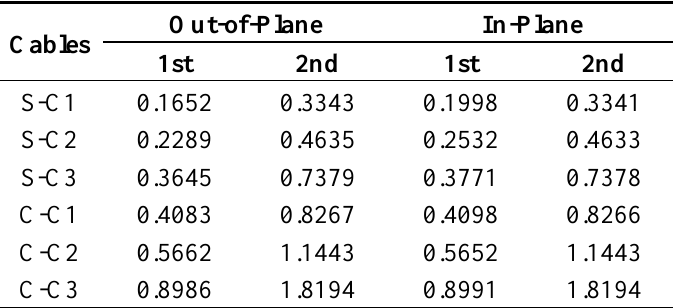
Table 6. Natural frequencies of stay cables (units: Hz).